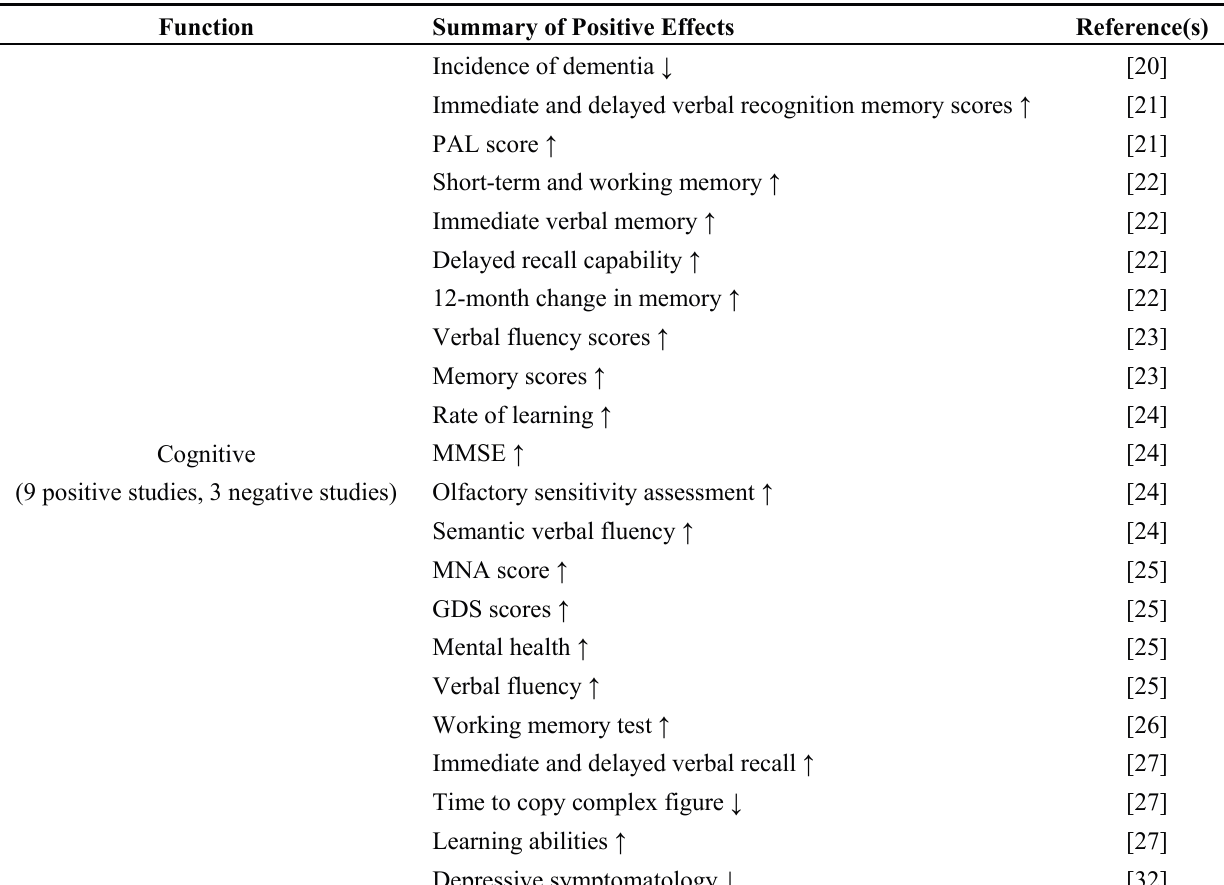
Table 1. Summary of trials evaluating the effects of omega-3 FAs in older